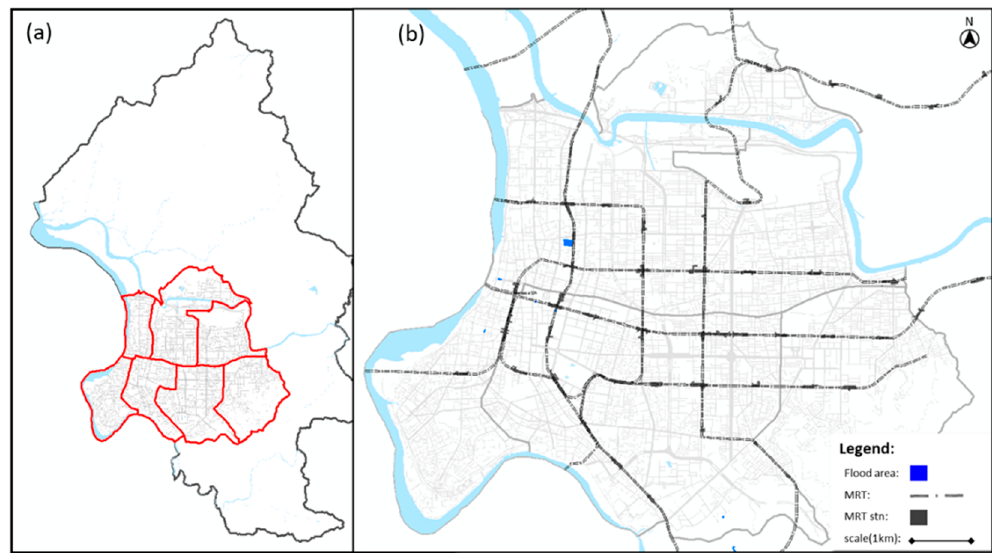
Figure 2. Research area and the flood potential map. ( a ) Research area comparing to the boundary of Taipei City; ( b ) flood potential maps under 78.8 mm/h precipitation intensity.